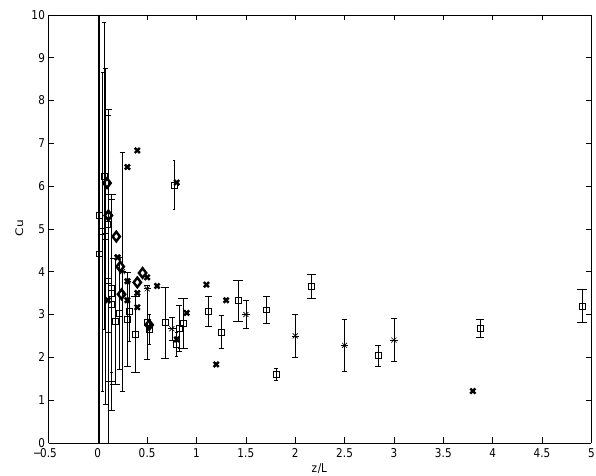
Fig. 3. Values of the constant C u of the Monin-Obukhov similarity theory for the non-dimensional velocity gradient given by Eq. (11). The values of C u are plotted against non-dimensional parameter z/L , accounting both for the stability of the surface layer and the height of the computational level in LES. Squares represent LES data; other symbols represent atmospheric